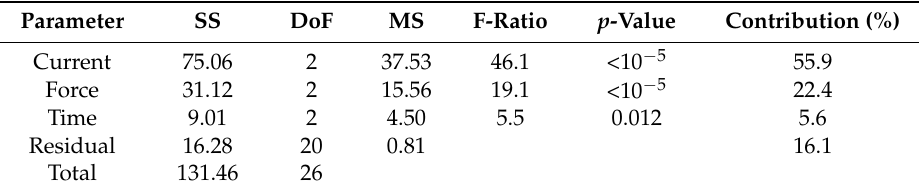
Table 5. ANOVA analysis of the shear tension strength values of the spot welds. SS: sum of squares; DoF: degree of freedom; MS: mean square; Fischer (F)-ratio; probability ( p )-value.